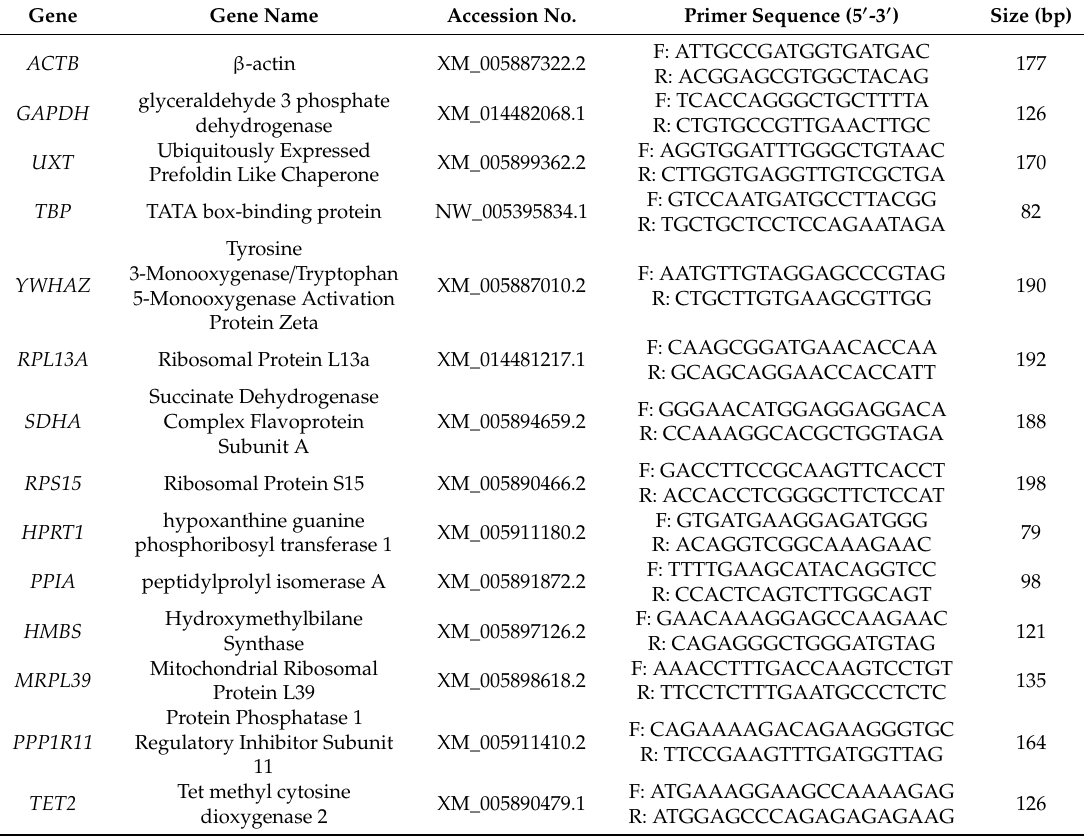
Table 1. Gene-specific primers for candidate